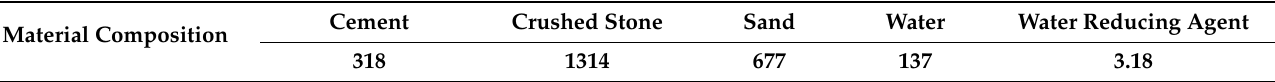
Table 4. Mix proportion of ordinary concrete (kg/m 3 ).